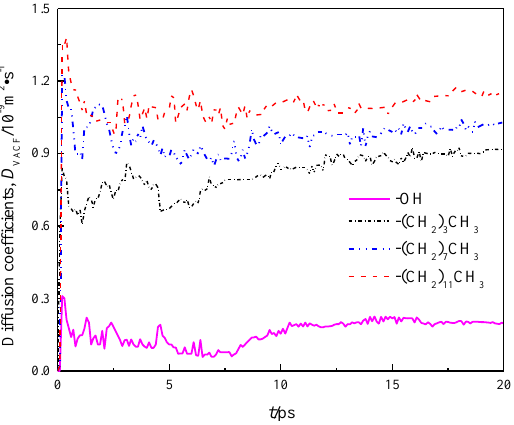
Figure 9. Diffusion coefficient D VACF of water in a nanochannel with different surface characteristics. the Green–Kubo method, as well as the diffusion coefficients in x , y , and z directions are listed in Table